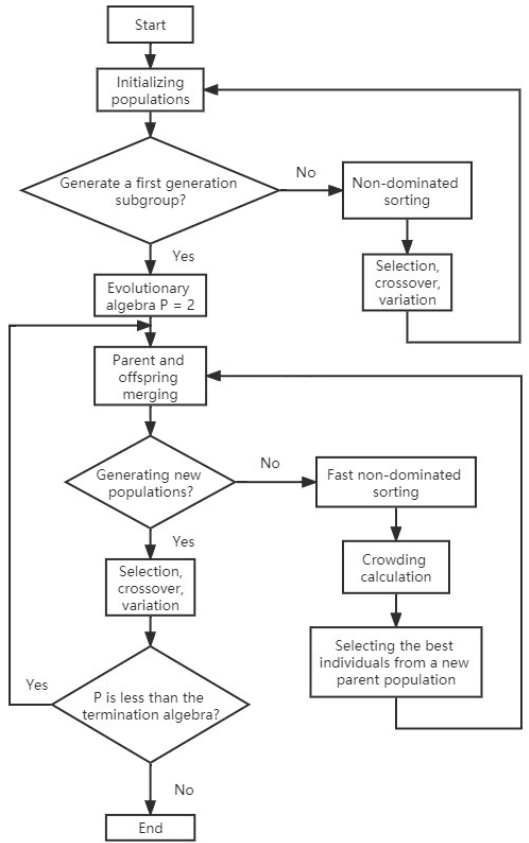
Figure 1. NSGA-II algorithm flow chart.